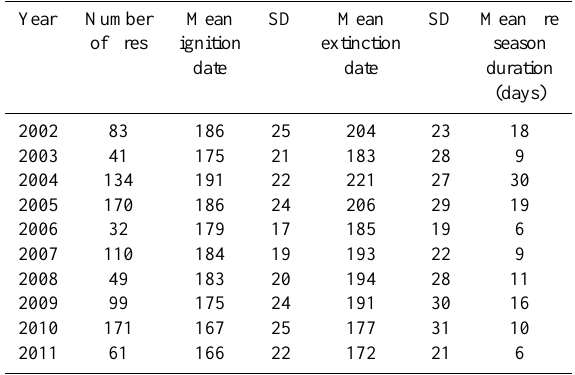
Table 1. Number of fires, mean and standard deviation (SD) ignition and extinction dates and mean fire season duration.